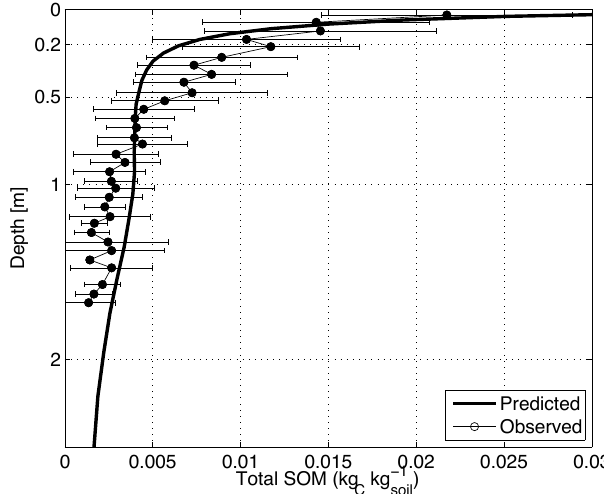
Figure 3. Predicted and observed SOM content. Observed values are represented as average and standard deviation of 618 observa- tions from grasslands extracted from the NSCN